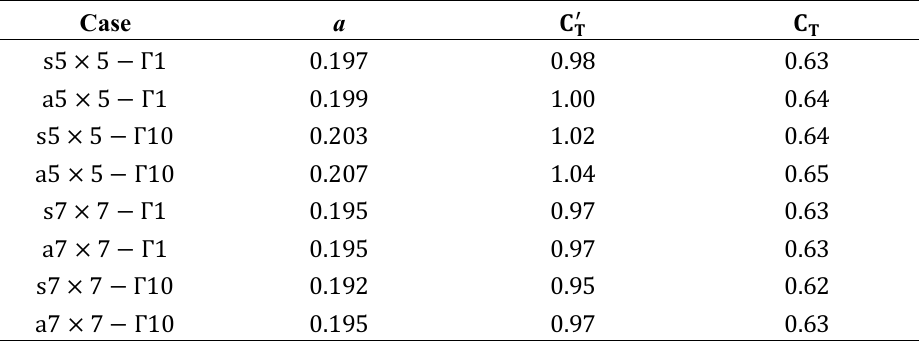
Table 3. The values of (cid:1853) , C Case a (cid:1777) (cid:1794)(cid:4593) (cid:1777)